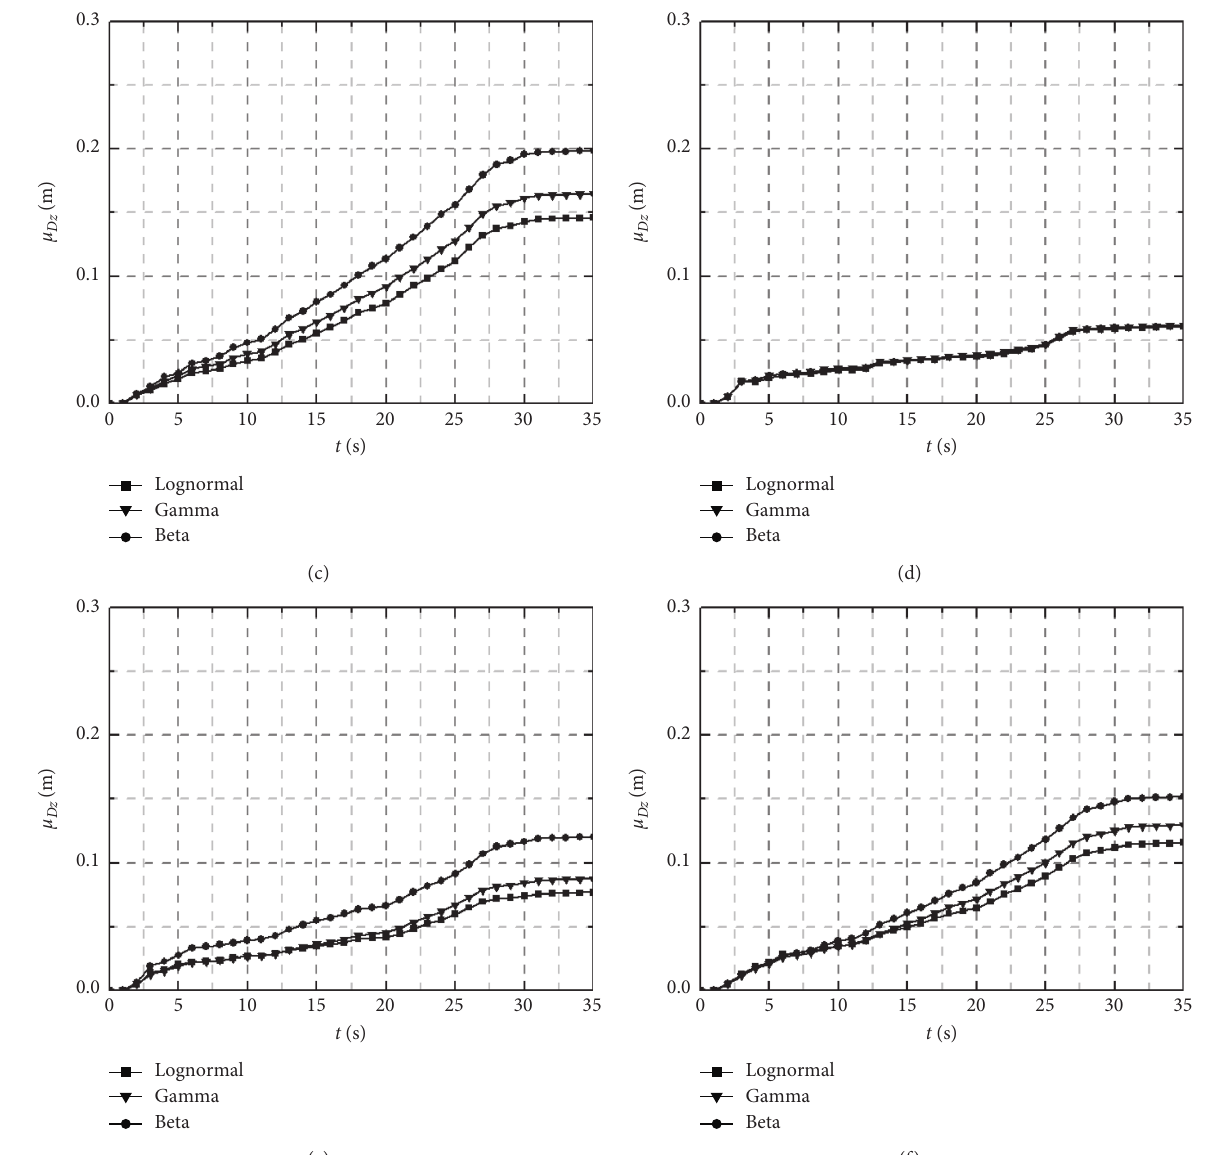
Figure 7: Time history curve of μ CoV G � 0.5; (d) δ x � 60 m and CoV G � 0.1; (e) δ x � 60m and CoV G � 0.3; (f) δ x � 60m and CoV G �